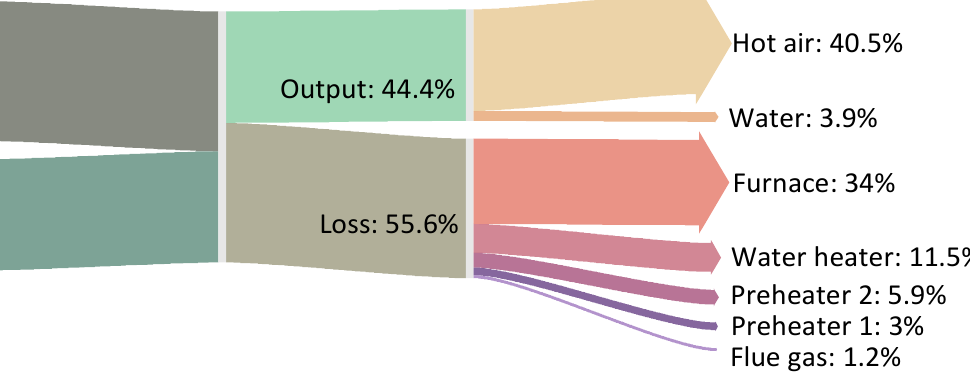
Figure 6. Flow diagram of exergy distribution.